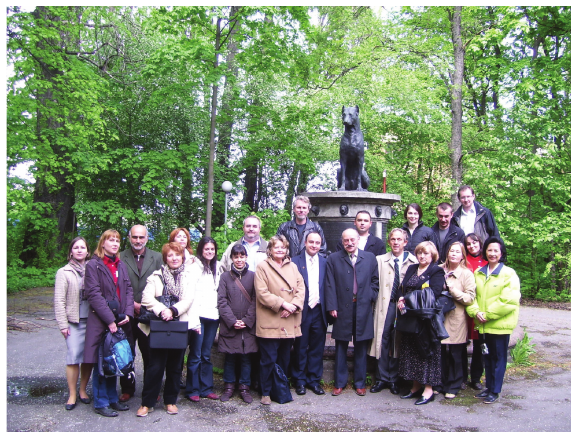
Figure 2: A group of conference speakers near the famous “Monument to the Dog” (commissioned by Ivan Pavlov) at the Institute of Experimental